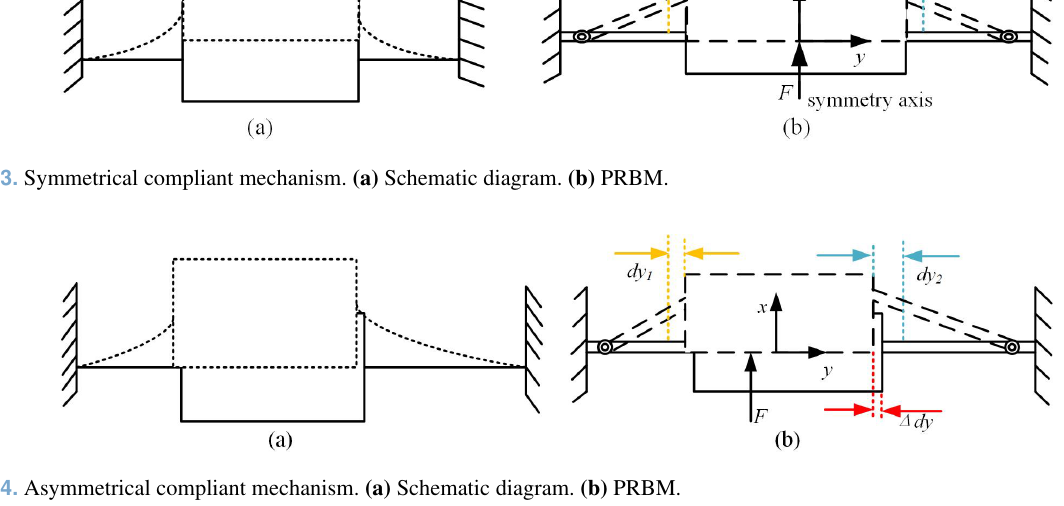
Figure 4. Asymmetrical compliant mechanism. (a) Schematic diagram. (b) PRBM.